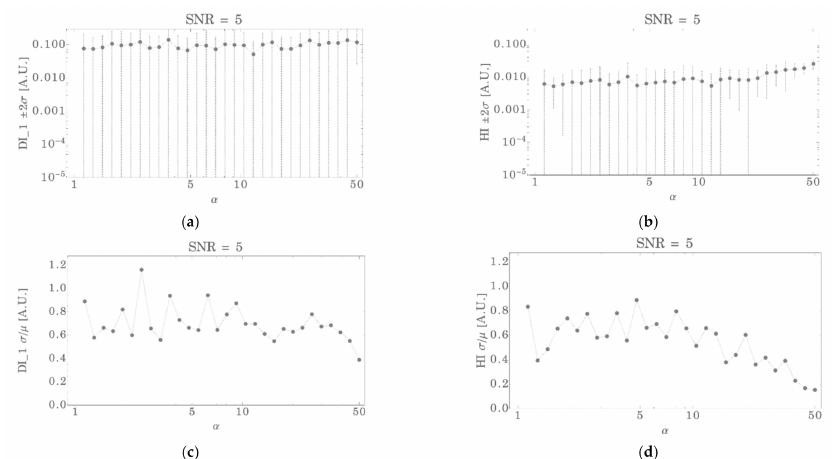
Figure 7. Mean value and standard deviation ( ± 2 σ ) of the estimators depending on the amount of damage α . ( a ) Double logarithmic scale representation of damage indicator DI 1 @ SNR = 5 dB; ( b ) double logarithmic scale representation of the proposed damage indicator HI @ SNR = 5 dB; (cid:16) (cid:17) σ ( c ) for DI 1 @ SNR = 5 dB; ( d ) µ